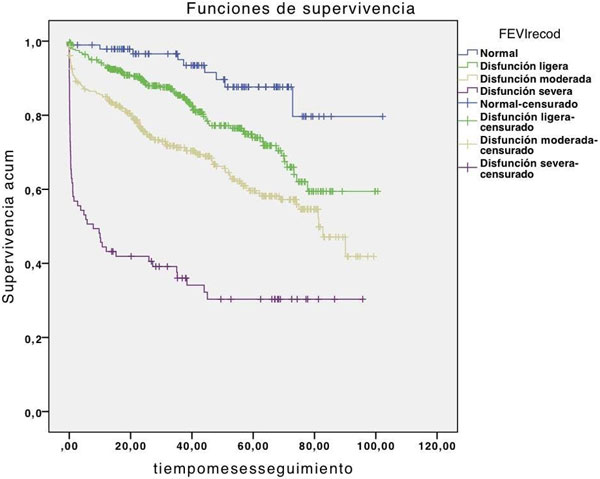
FEVI and prognosis.